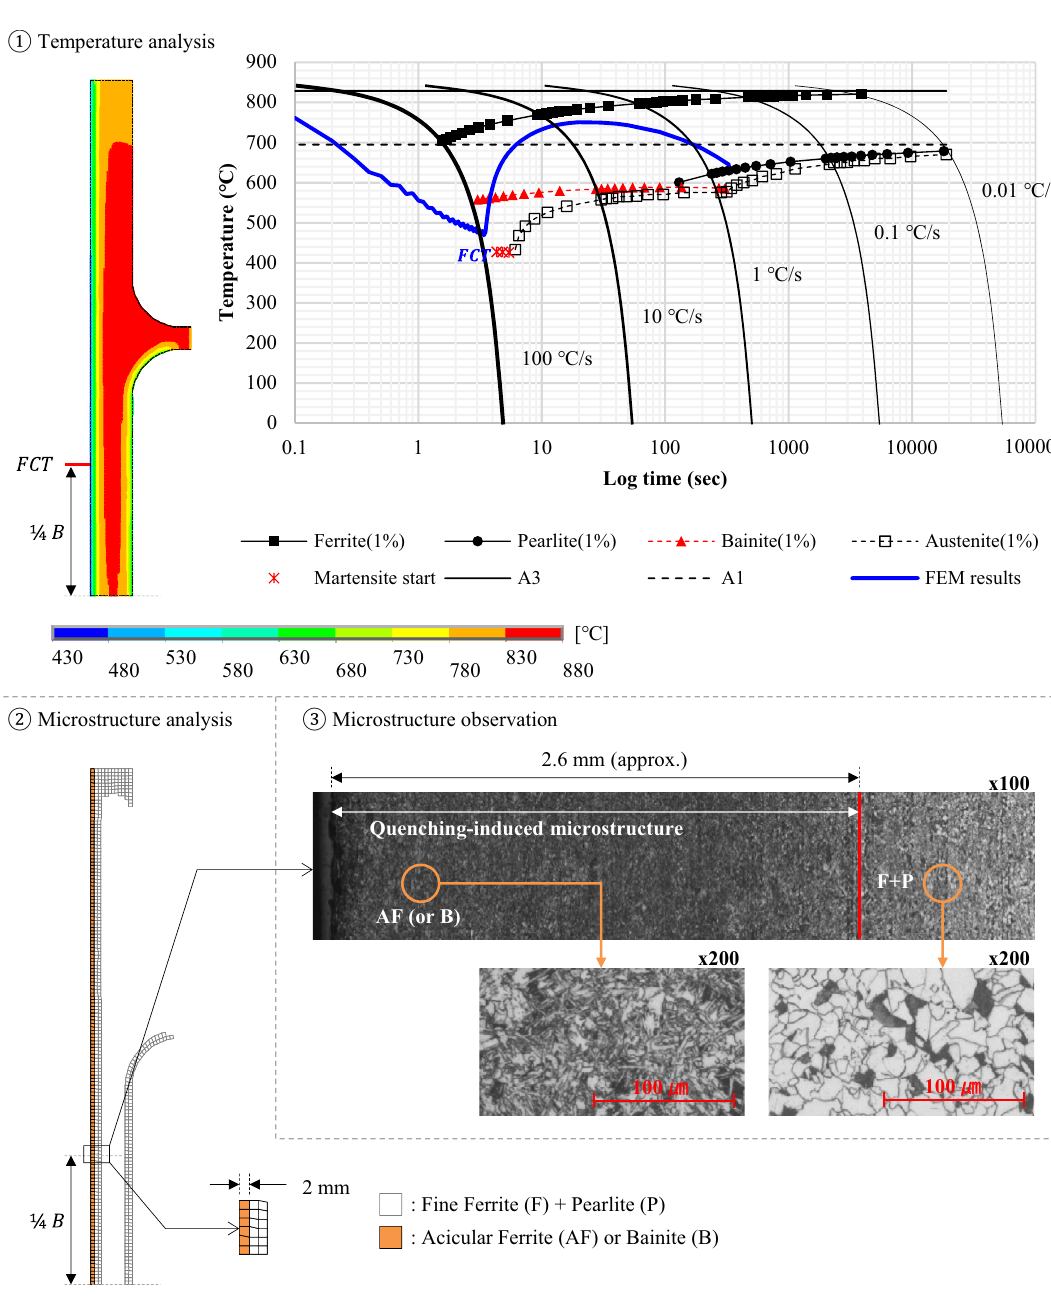
Figure 14. Comparison of microstructure observations of computation